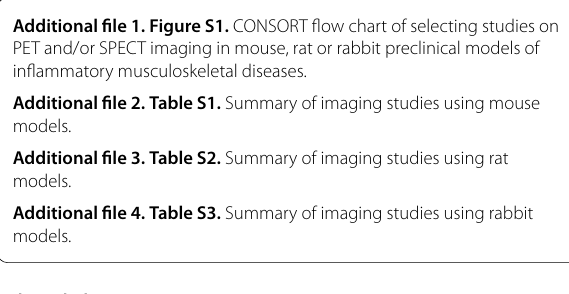
Additional file 2. Table S1. Summary of imaging studies using mouse models. Additional file 3. Table S2. Summary of imaging studies using rat models. Additional file 4. Table S3. Summary of imaging studies using rabbit